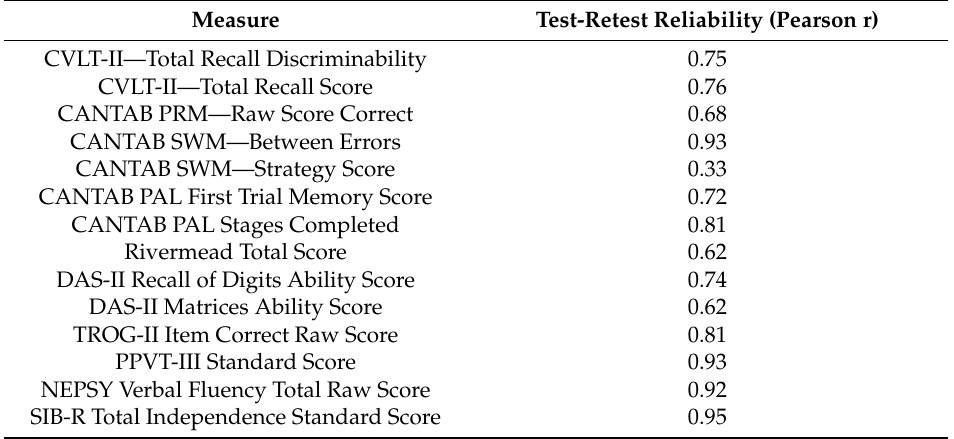
Table 1. Pearson r values for test-retest reliability for various measures used in the pilot memantine